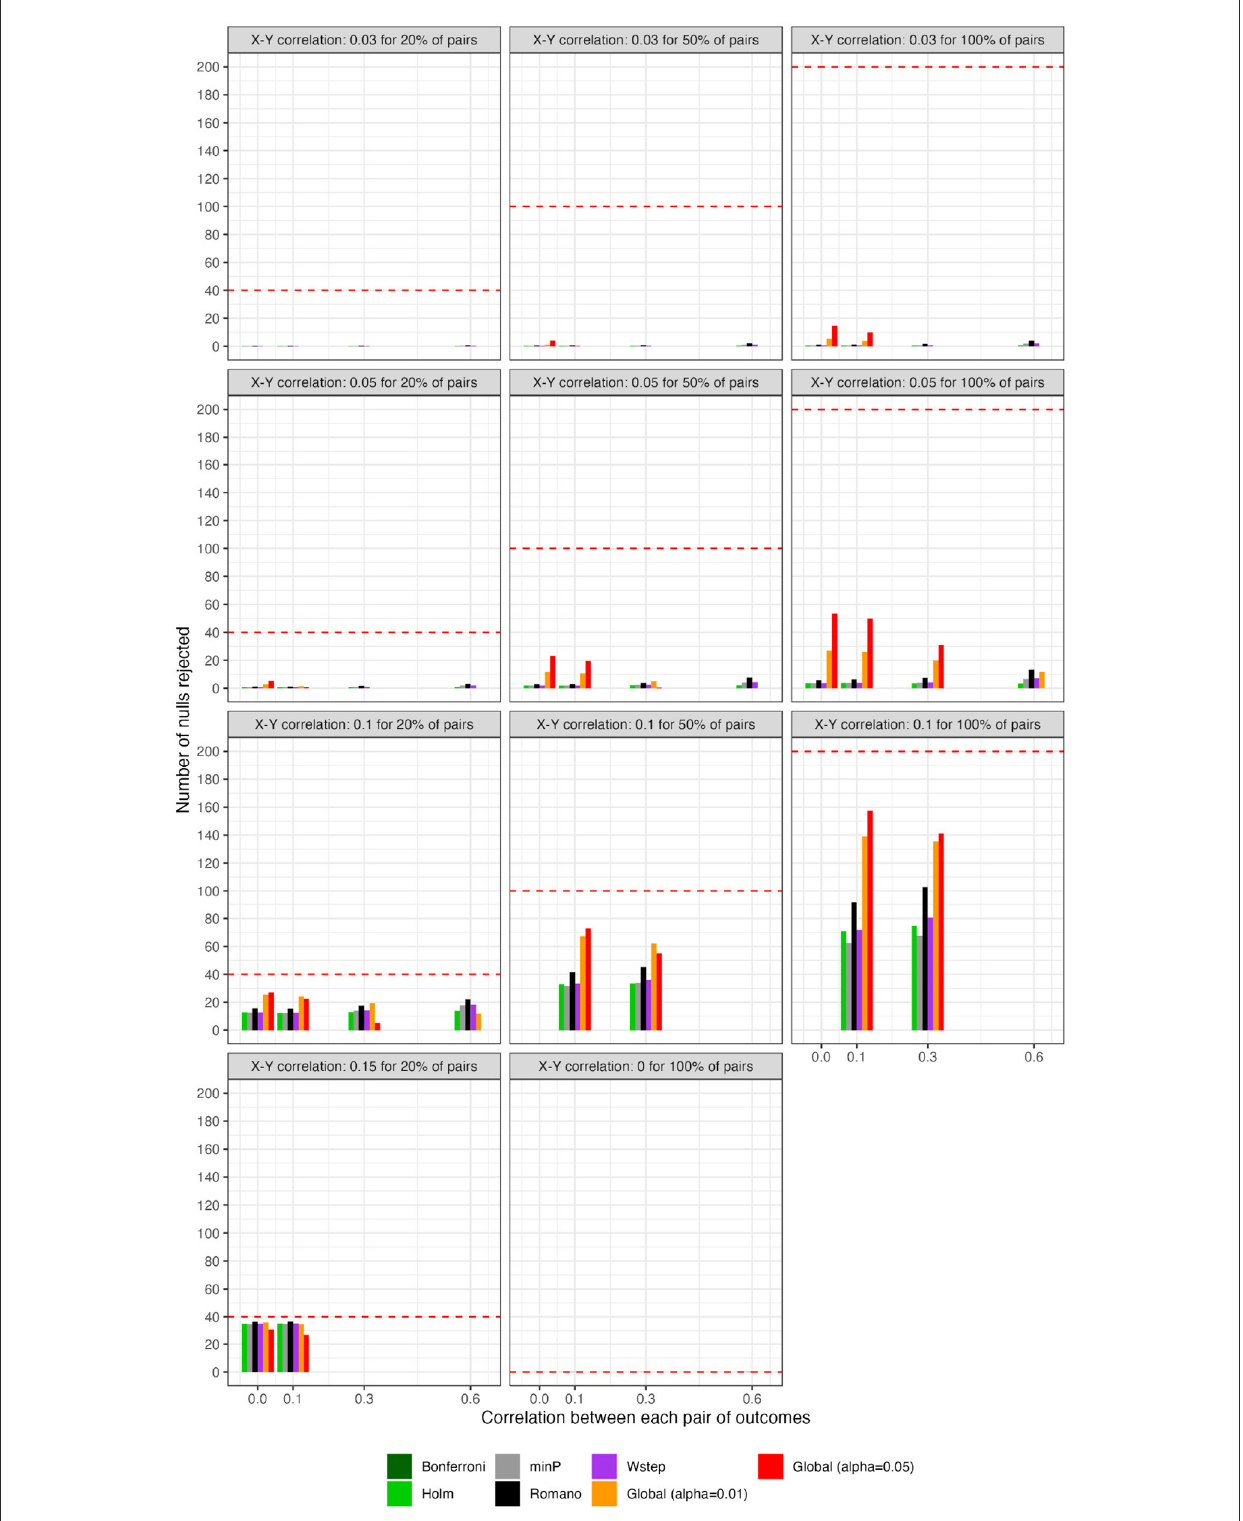
FIGURE6 For scenarios with 200 outcomes, number of rejected null hypotheses at familywise-controlled α W = 0.05 based on existing FWER-control procedures and on the excess hits. “Global (alpha = 0.01)” and “Global (alpha = 0.05)”: proposed methods. Red dashed line: Actual number of false null hypotheses ( q × W